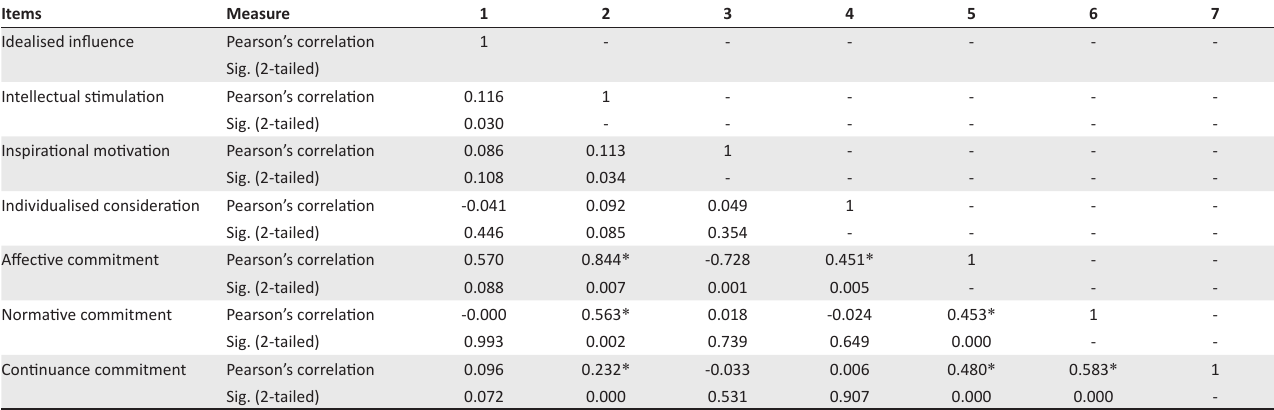
TABLE 4: Relationship between perceived transformational leadership style constructs and employee organisational commitment facets. Items